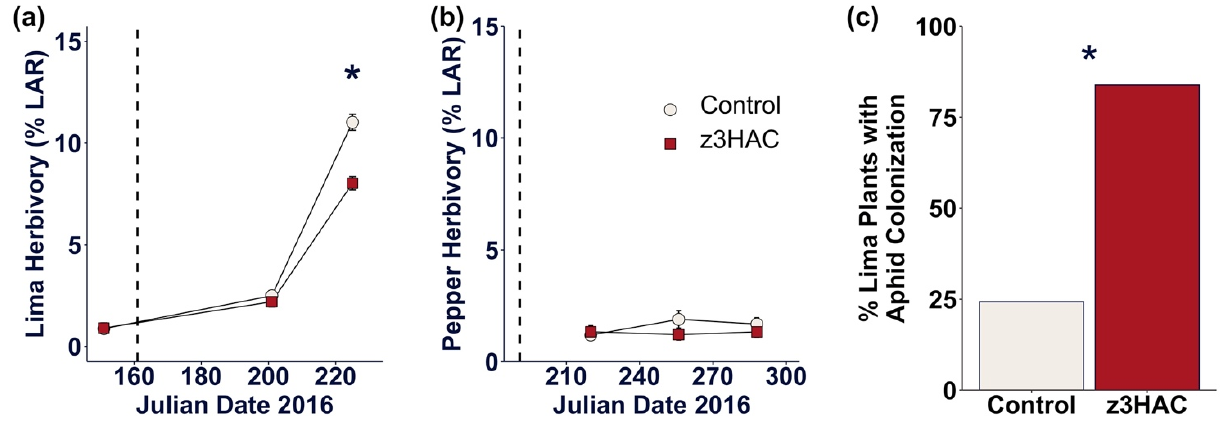
Figure 6. Herbivore damage on Capsicum annuum (pepper) and Phaseolus lunatus (lima bean) plants in a common garden field experiment. Chewing damage on ( a ) pepper and ( b ) lima bean plants was determined using a visual estimation technique (see Methods). Open circles represent control plants (receiving lanolin-filled vials); filled squares represent plants receiving a persistent application 10 ng/h cis -3-hexenyl acetate ( z 3HAC) dissolved in lanolin. Dropdown lines indicate the initial application of z 3HAC treatment. Points represent the averages +/ − SE. Repeated-measures ANOVAs (aov in R) were followed by Tukey HSD contrasts. ( c ) Aphis faba colonization on lima bean plants. Bars represent the percentage of plants in each group where A. faba were observed. Asterisks (*) represent P < 0.05 between treatment and controls. See Supplemental Table S5 for complete statistics.